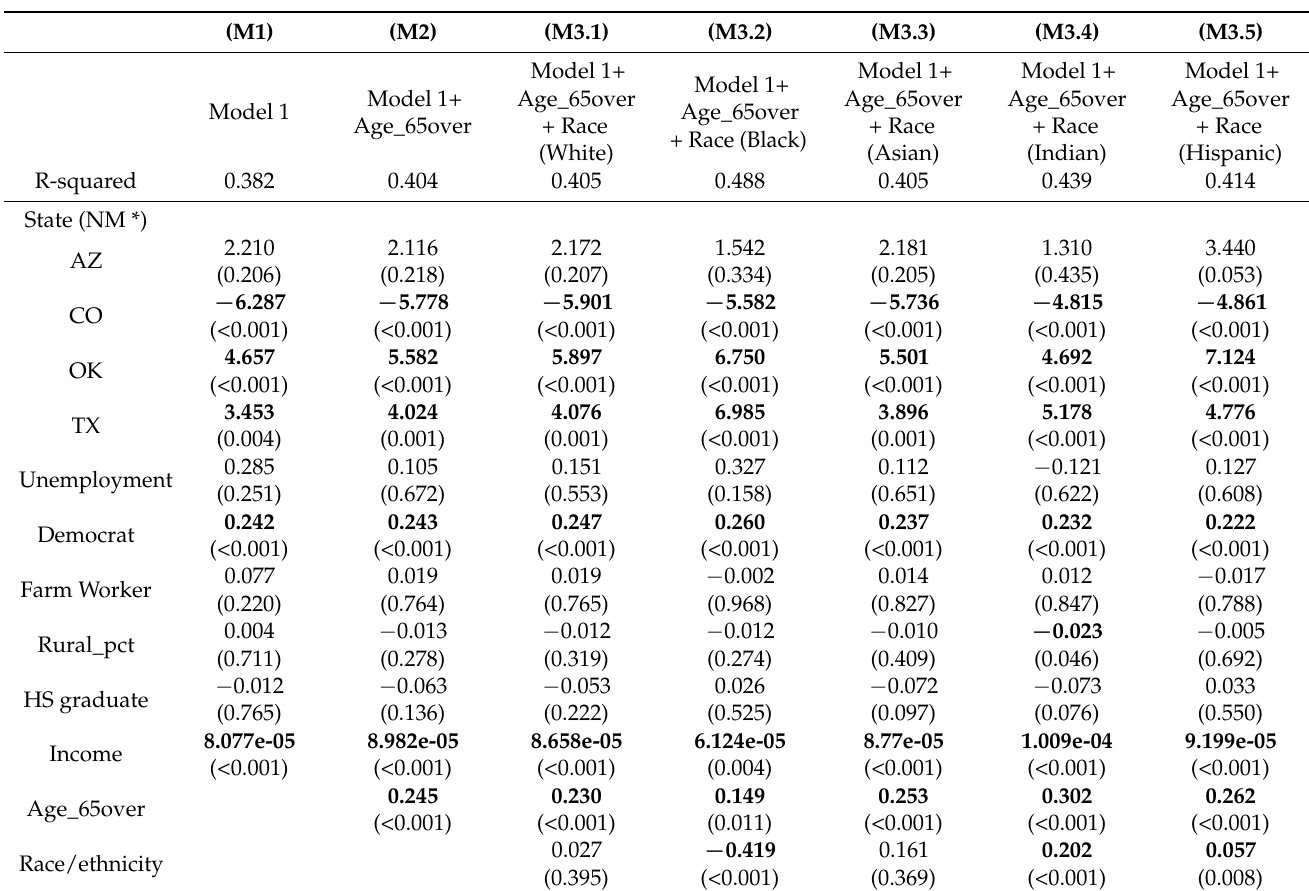
Table 3. Associations between vaccination rates and the counties’ characteristics in the regres- sion